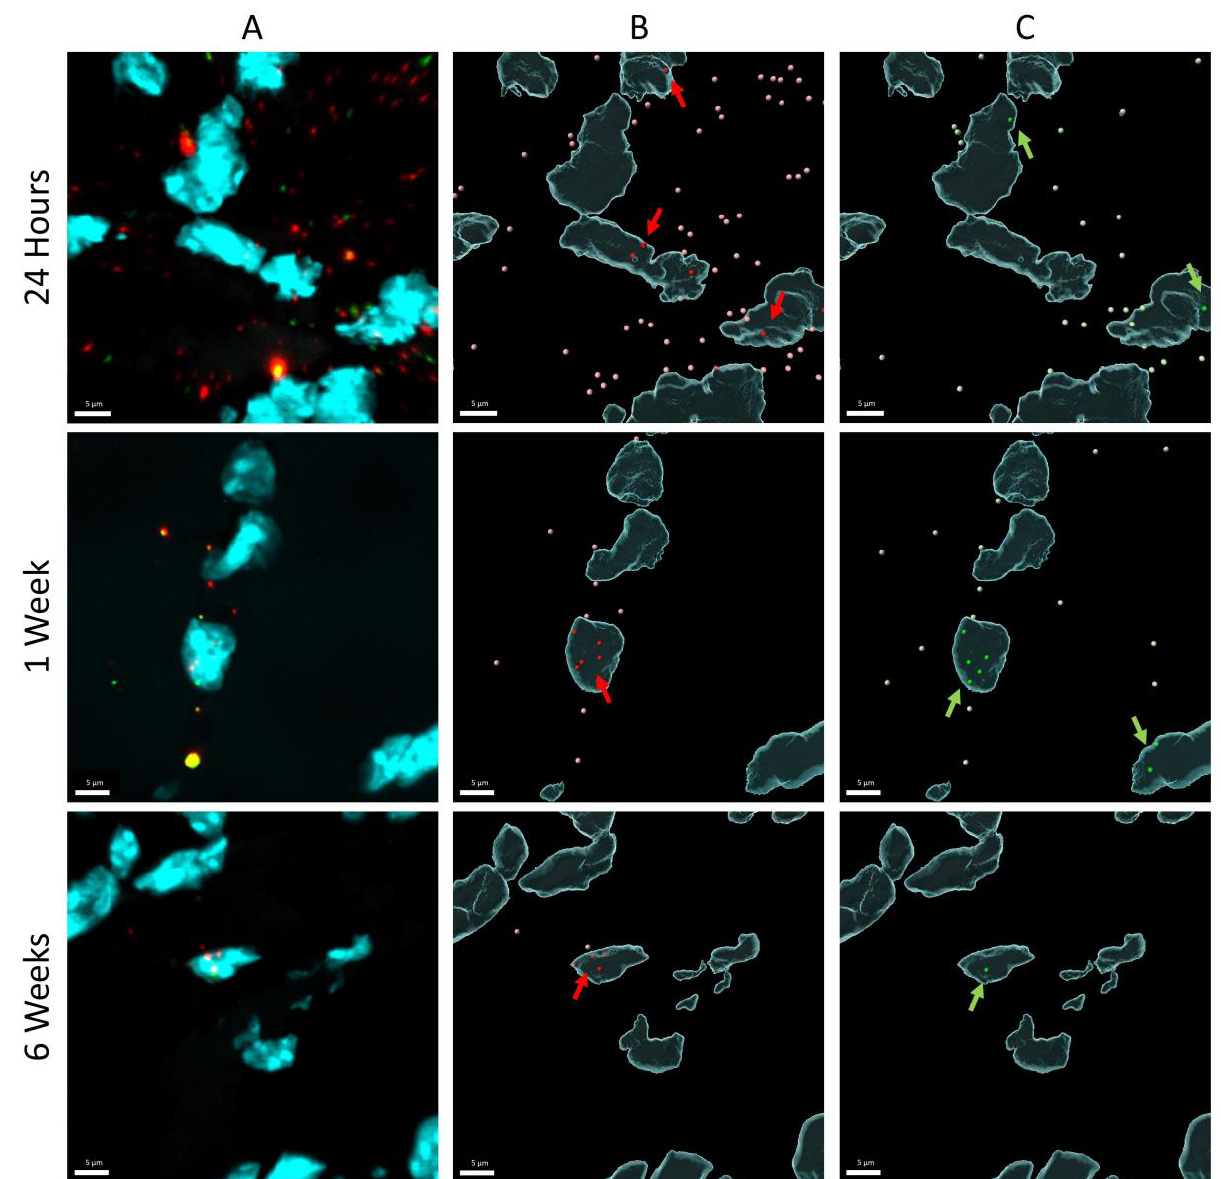
Figure 4. Representative DNA scope Image Processing. Balb/c mice received intramuscular pDNA electrotransfer of 60 µg pDNA (equimolar mixture pCAG-4D5-HC and pCAG-4D5-LC) in the tibialis anterior muscle. DNA scope assay on 5-µm muscle slices, visualized with confocal microscopy for 3 different time points (24 h, 1 week, and 6 weeks). ( A ) Confocal microscopy signal (three channels: (i) DAPI nuclei signal cyan, (ii) pCAG-4D5-HC Opal 570 signal red, (iii) pCAG-4D5-LC Opal 690 signal green). ( B , C ) surfaces and spots generated with Imaris software for each channel separately ( B ) spots pCAG-4D5-HC pink (extranuclear)/red (nuclear), ( C ) spots pCAG-4D5-LC light green (extranuclear)/green (nuclear). Arrows indicate regions with nuclear pDNA.